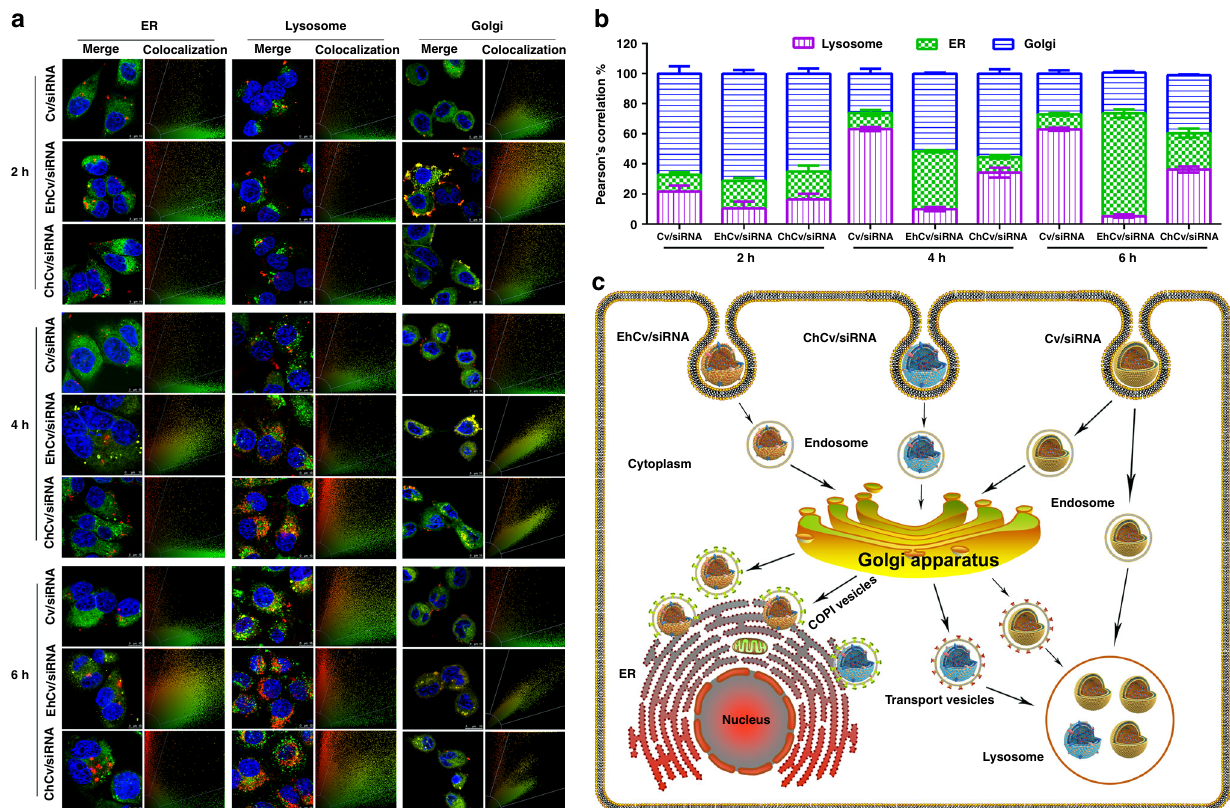
Fig. 5 Intracellular traf fi cking pathways of various small interfering RNA (siRNA)-loaded nanoparticles (NPs) on MCF-7 cells. a Representative colocalization images of different NPs in endoplasmic reticulum (ER), lysosomes, and Golgi apparatus at different times detected by confocal laser scanning microscope. The yellow dots represent the colocalization of fl uorescence-labeled organelles (green) and Cy5-siRNA (red). b Quantity analysis of intracellular colocalization ratios of different NPs in ER, lysosomes, and Golgi at different times. The colocalization ratios were calculated based on the Pearson ’ s correlation coef fi cient from multiple images ( n = 3) with a normalized calculation method. c Schematic illustration of intracellular traf fi